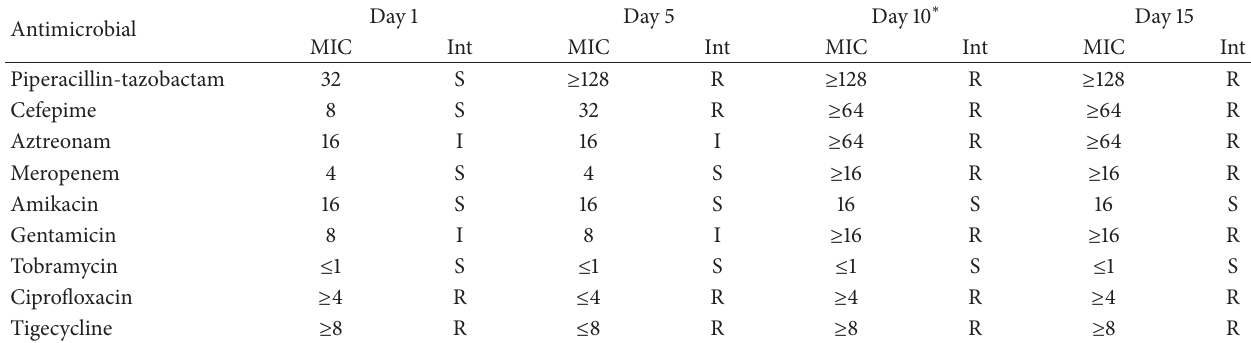
Table 2: Antimicrobial susceptibility of Pseudomonas aeruginosa isolated from the blood.